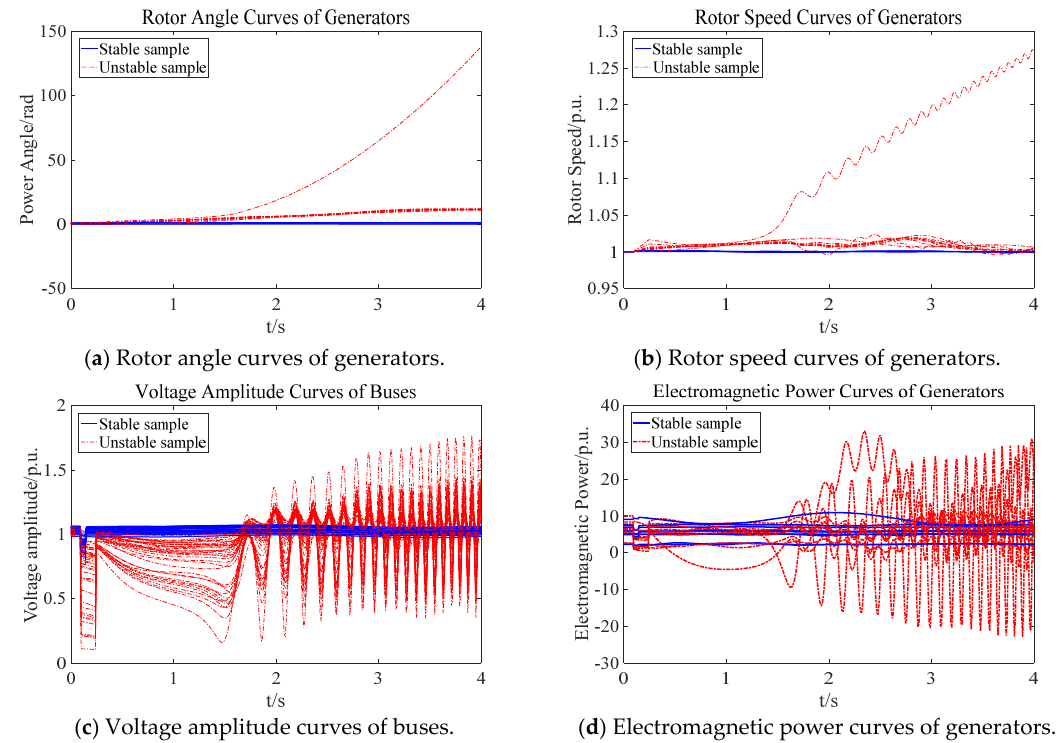
Figure 6. Simulation curves of the 4 types of features for stable and unstable samples.